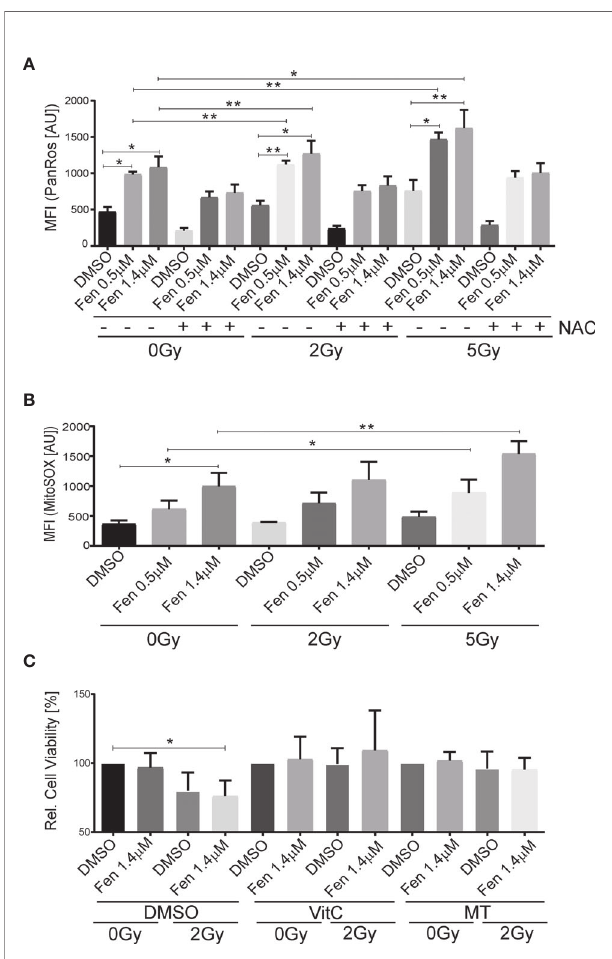
FIGURE 2 | The combination of fenretinide and ionizing radiation enhances the production of reactive oxygen species. (A, B) Mean fl uorescence index analysis of fl ow cytometry data of Rh4 cells treated with fenretinide (0.5/1.4 µM) and IR (2/5 Gy), in presence or absence of 15 mM N-acetylcysteine (NAC). Cells were stained with CellRox (4 µM) (A) and MitoSox (10 µM) (B) . *p</=0.05, **p</=0.01. (C) Cell viability of Rh4 cells treated with fenretinide (1.4 µM) and IR (2 Gy) in presence or absence of the mitochondria speci fi c ROS scavenger MitoTempo (300 µM) or Vitamin C (50 µM) as determined by WST assay.